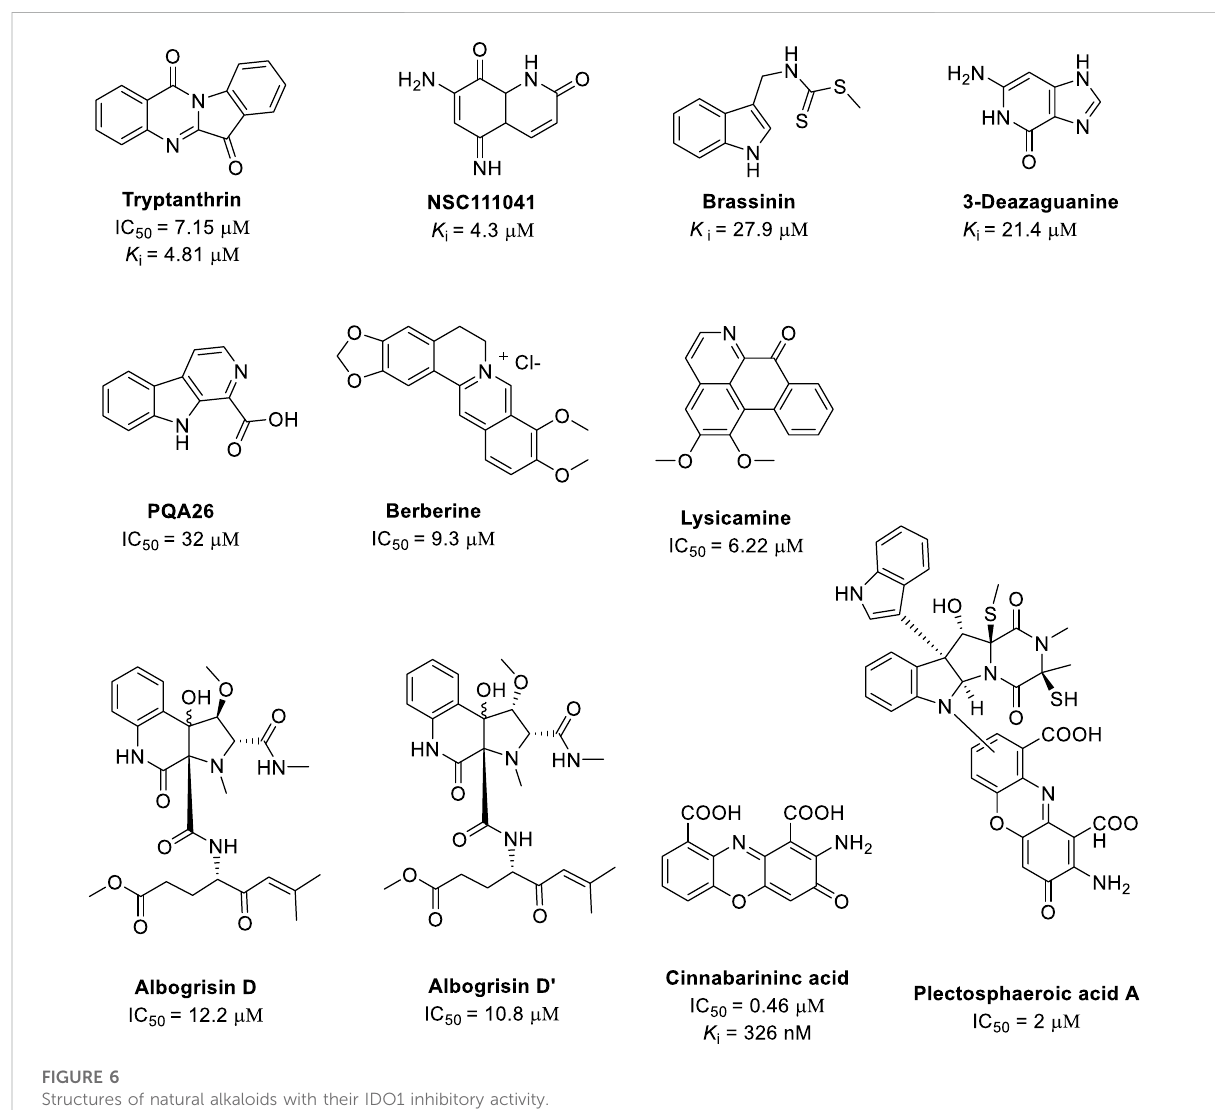
FIGURE 6 Structures of natural alkaloids with their IDO1 inhibitory